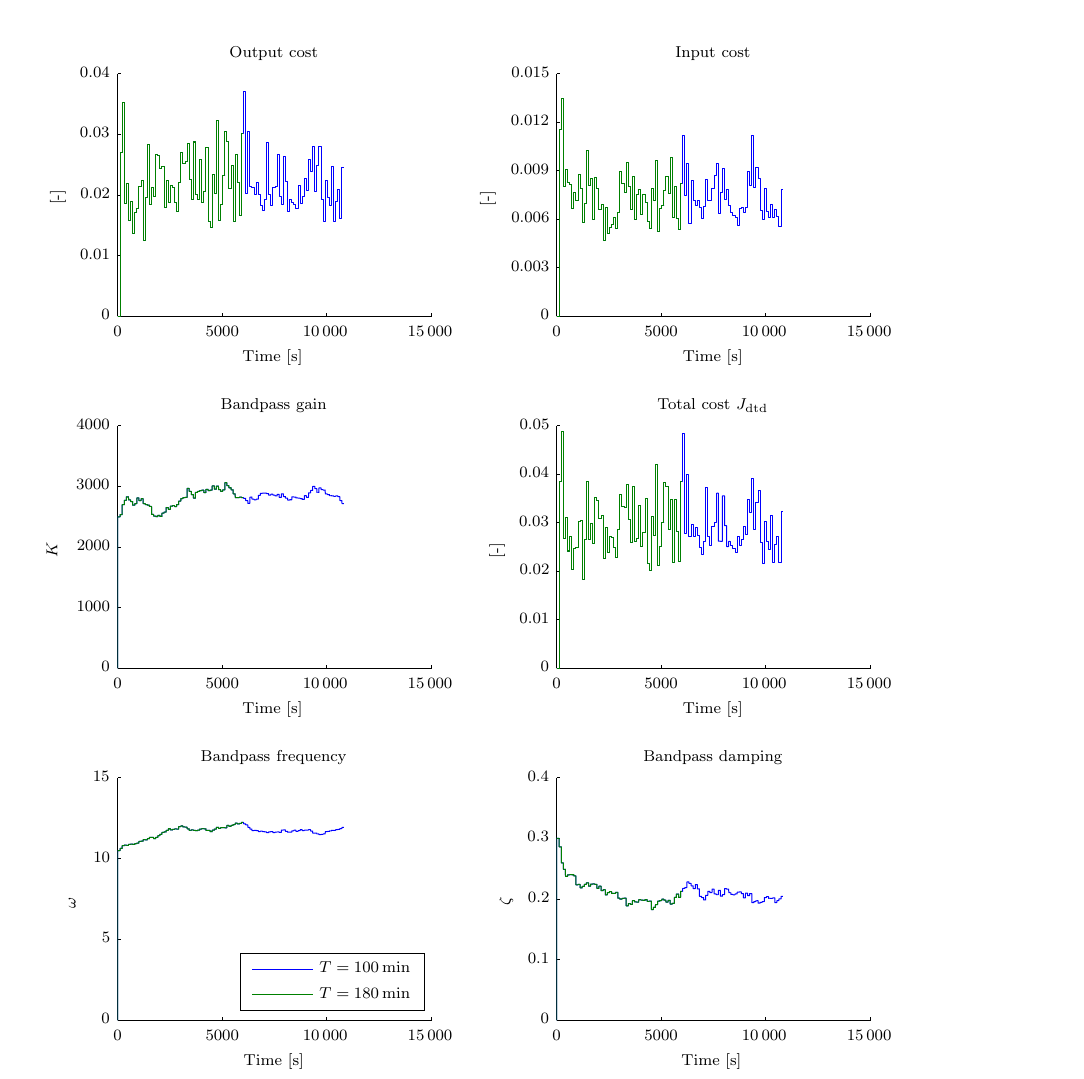
Figure C1. Comparison of IFT performance for different simulation lengths. The simulation settings used are a wind speed of 14ms − 1 , a turbulence intensity of 10%, step size γ = 0 . 3, input weighting factor λ = 5 × 10 − 7 , and scaling factor F =